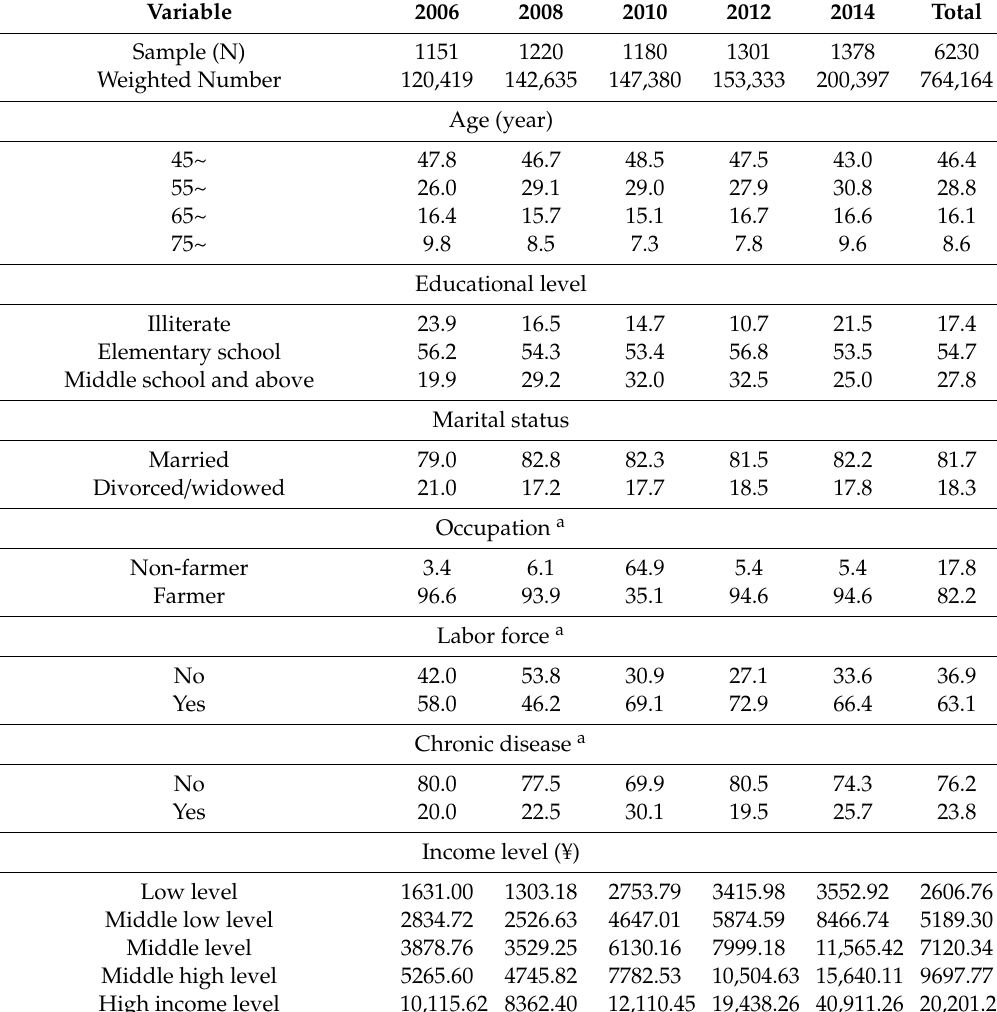
Table 2. Distribution of demographic characteristics of MAEF in three counties between 2006 and 2014